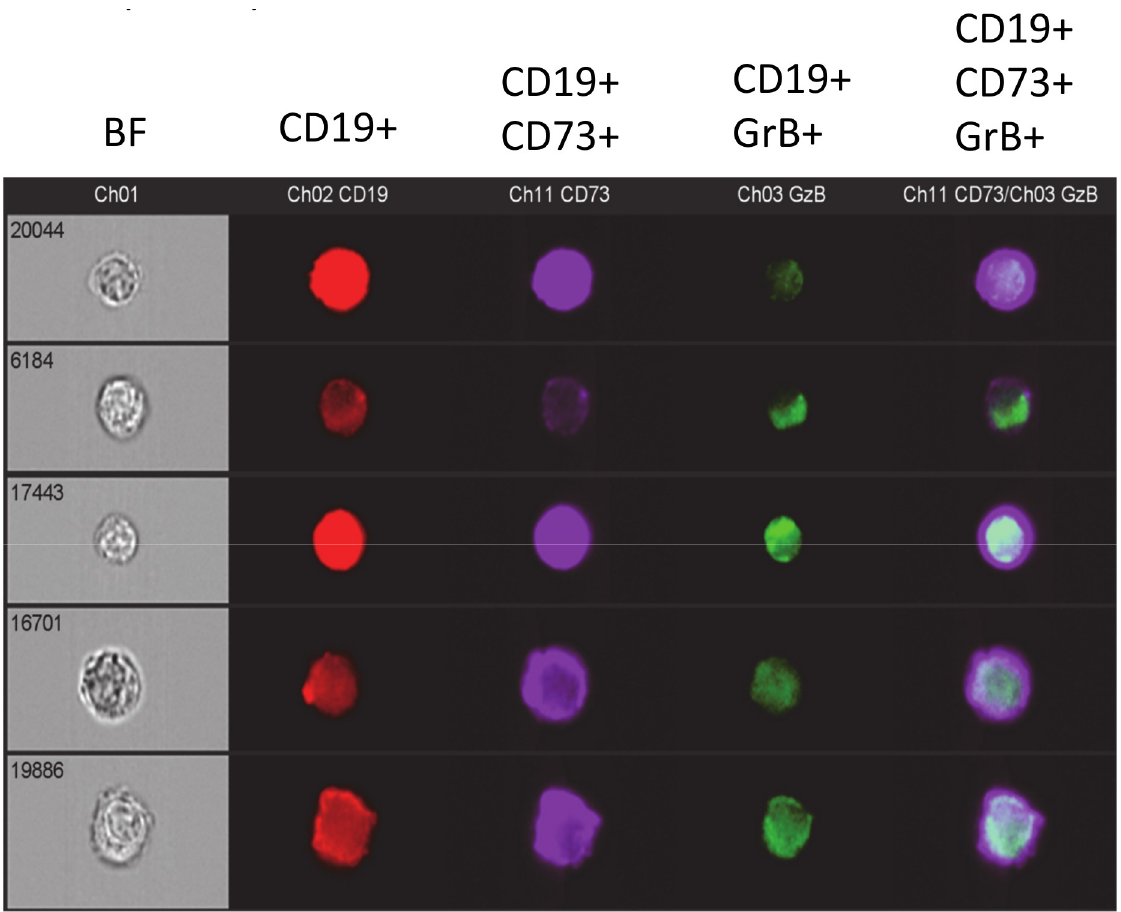
Fig 7. Flow Cytometry Imaging of CD73 + GrB + B cells. Splenocytes from PyNL immune mice were co-incubated with PyNL infected erythrocytes for 4 days and then surface stained with fluorochrome-conjugated antibodies specific for CD19, CD73, and CD8 followed by intracellular staining using a monoclonal antibody specific for granzyme B (GrB). The cells were incubated with violet live-dead stain to differentiate viable from nonviable cells and then visualized using an ImageStream system via bright field (BF) or fluorescence mode at 60X magnification (CD8 + cells were excluded from the gates). Using fluorescence mode, CD73 + B cells expressing GrB were visualized by placing a gate on live CD19 + cells (red) followed by gating on CD73 + (purple), GrB + (green) or CD19 + CD73 + GrB + cells (purple and green).